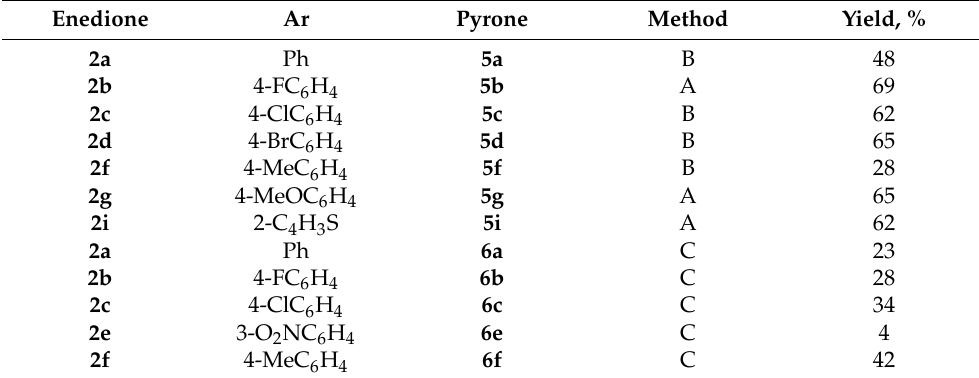
Table 3. The scope of 4-pyrone synthesis via the one-pot oxidative cyclization of enediones 2 . Enedione Ar Pyrone Method Yield,